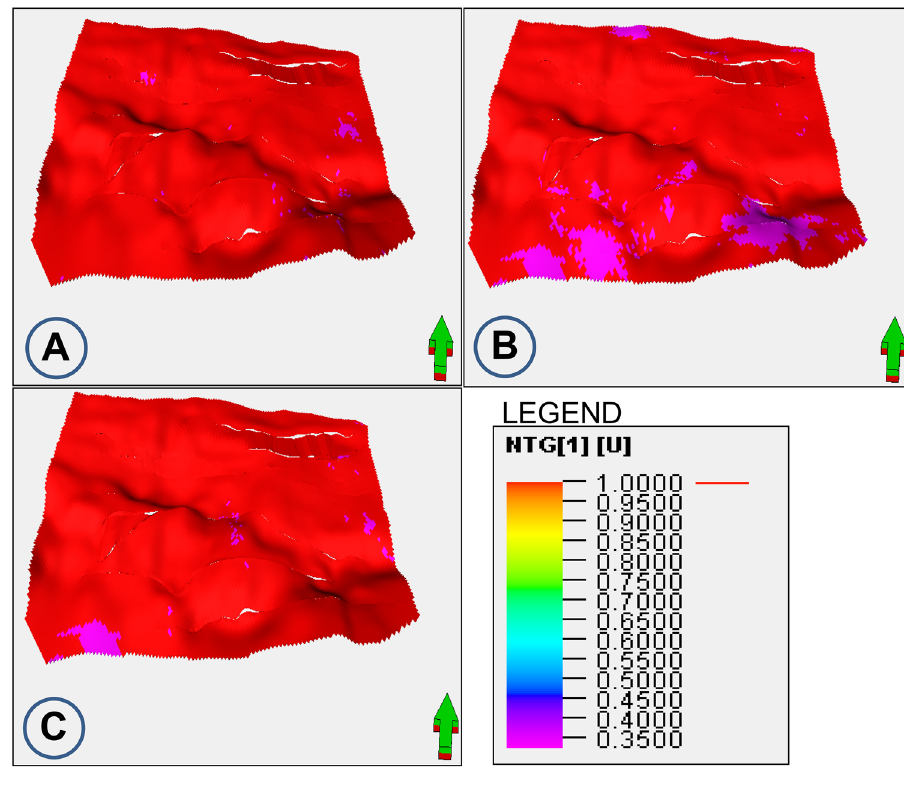
Fig. 11 Equiprobable realiza- tions of total porosity from K200